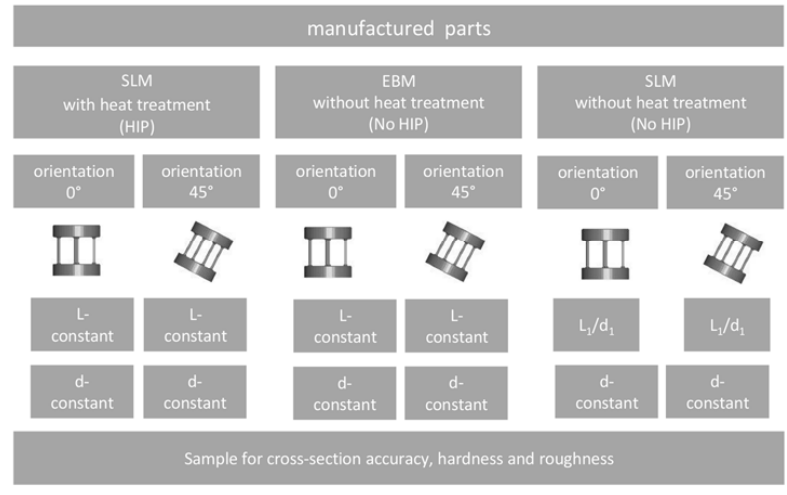
Figure 3. Overview of all manufactured parts as well as heat treatment conditions and orientation. Parts were built for compression testing (SLM (HIP) and EBM (No HIP) d ‐ and L ‐ constant; SLM (No HIP) d ‐ constant and L 1 / d 1 ), fabrication accuracy, determining cross section areas, hardness and roughness.